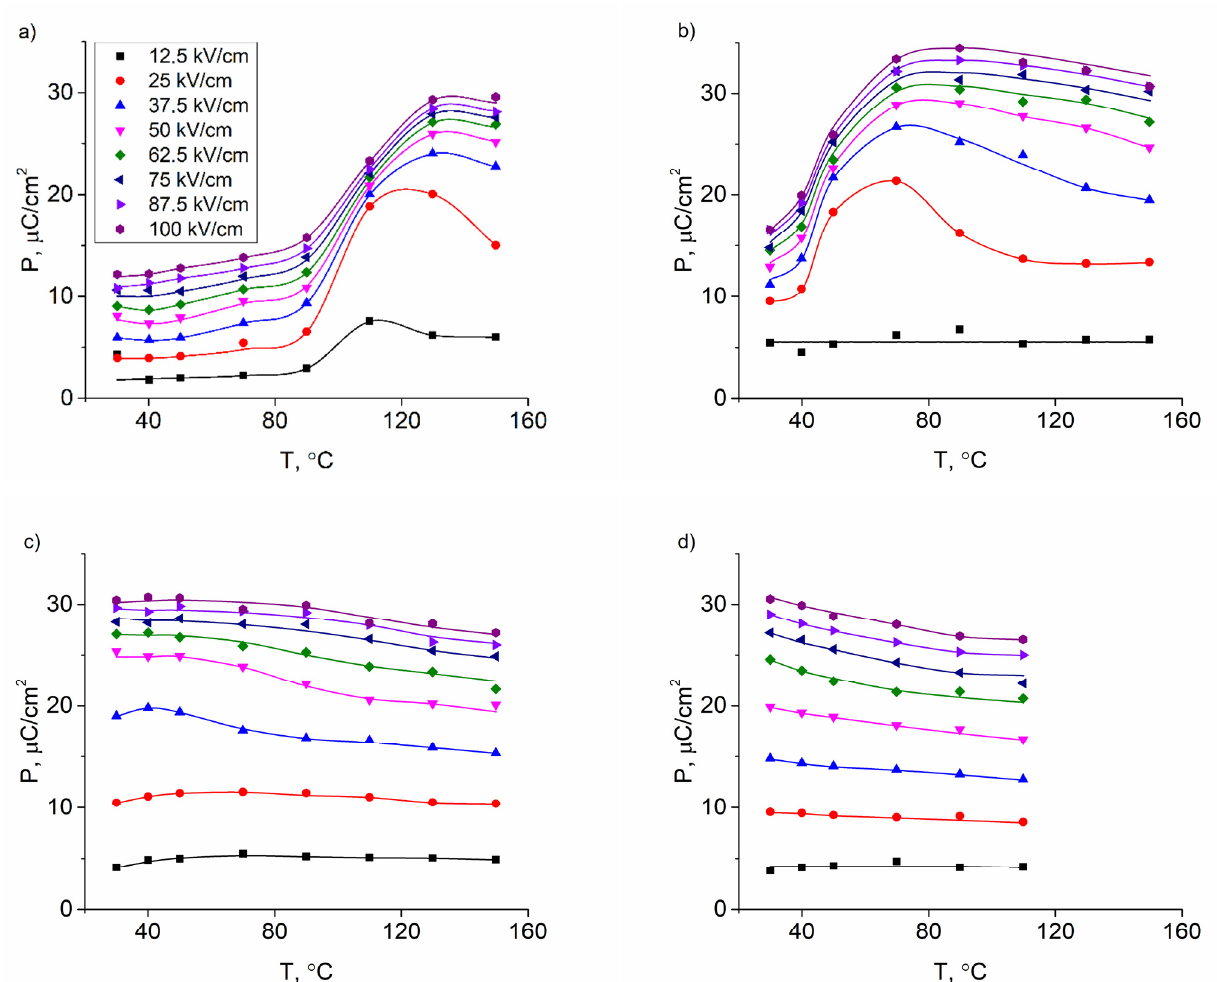
Figure 7. Temperature dependence of polarization at different electric fields for (1 − x)(0.8NBT- 0.2BT) − xCT compositions with x = 0.050 ( a ), x = 0.075 ( b ), x = 0.100 ( c ), and x = 0.125 ( d ), obtained from measurements of polarization current simultaneously with measurements of Δ T .